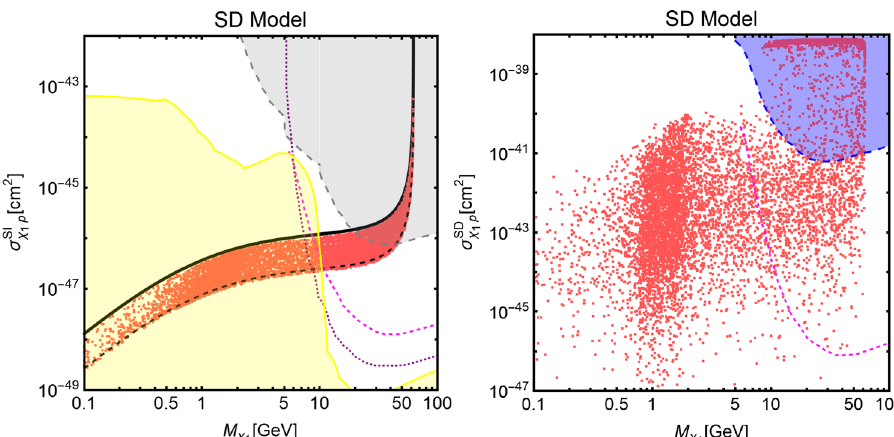
,σ SI ] (left panel) and Fig. 15 Model points in the planes [ M χ (red points). The gray/blue regions are excluded by the direct detection χ 1 p 1 bound from XENON1T on DM spin dependent and independent cross [ M χ ,σ SD ] (right panel) obtained from a survey of the parameter space χ 1 p 1 sections, the magenta and purple lines are the projected sensitivities of the fermionic singlet-doublet model, with the requirement of an from the XENONnT and DARWIN experiments, respectively, while invisible Higgs branching ratio of 2 . 5% < BR ( H → inv ) < 11% the yellow region in the left panel corresponds to the neutrino floor